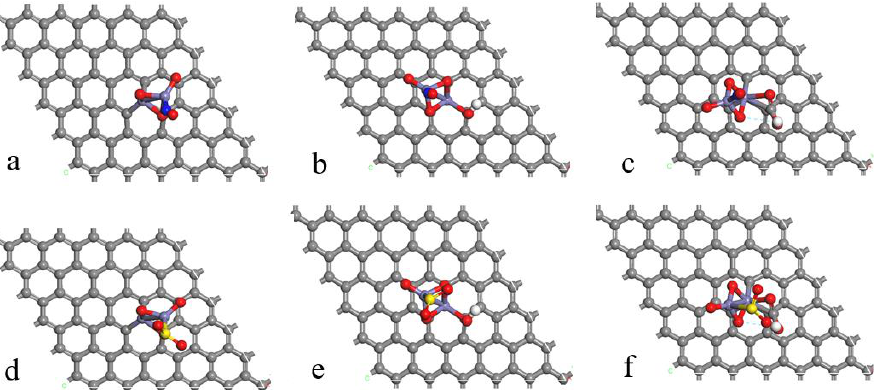
Figure 3. ( a – c ) Stable configurations of NO adsorption on Fe 2 O 3 /G def , Fe 2 O 3 /HyG, and Fe 2 O 3 /CyG. ( d – f ) Stable configurations of SO 2 adsorption on Fe 2 O 3 /G def , Fe 2 O 3 /HyG, and Fe 2 O 3 /CyG. The C atom is gray, the O atom is red, the Fe atom is purple, the H atom is white, the N atom is blue, and the S atom is yellow.